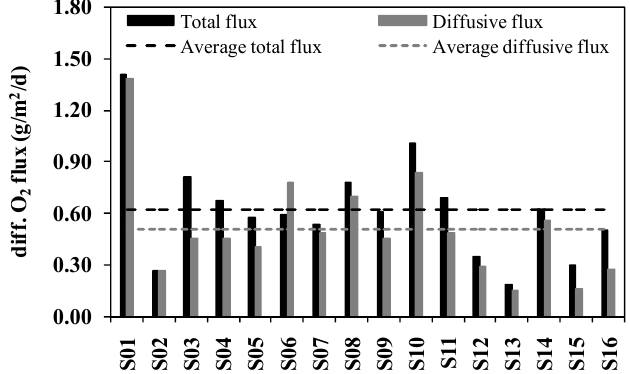
Figure 6. Sediment oxygen demand measured during August 2003. Total flux referring to SOD determined by core incubation and diffusive flux referring to SOD determined from microelectrode estimation.